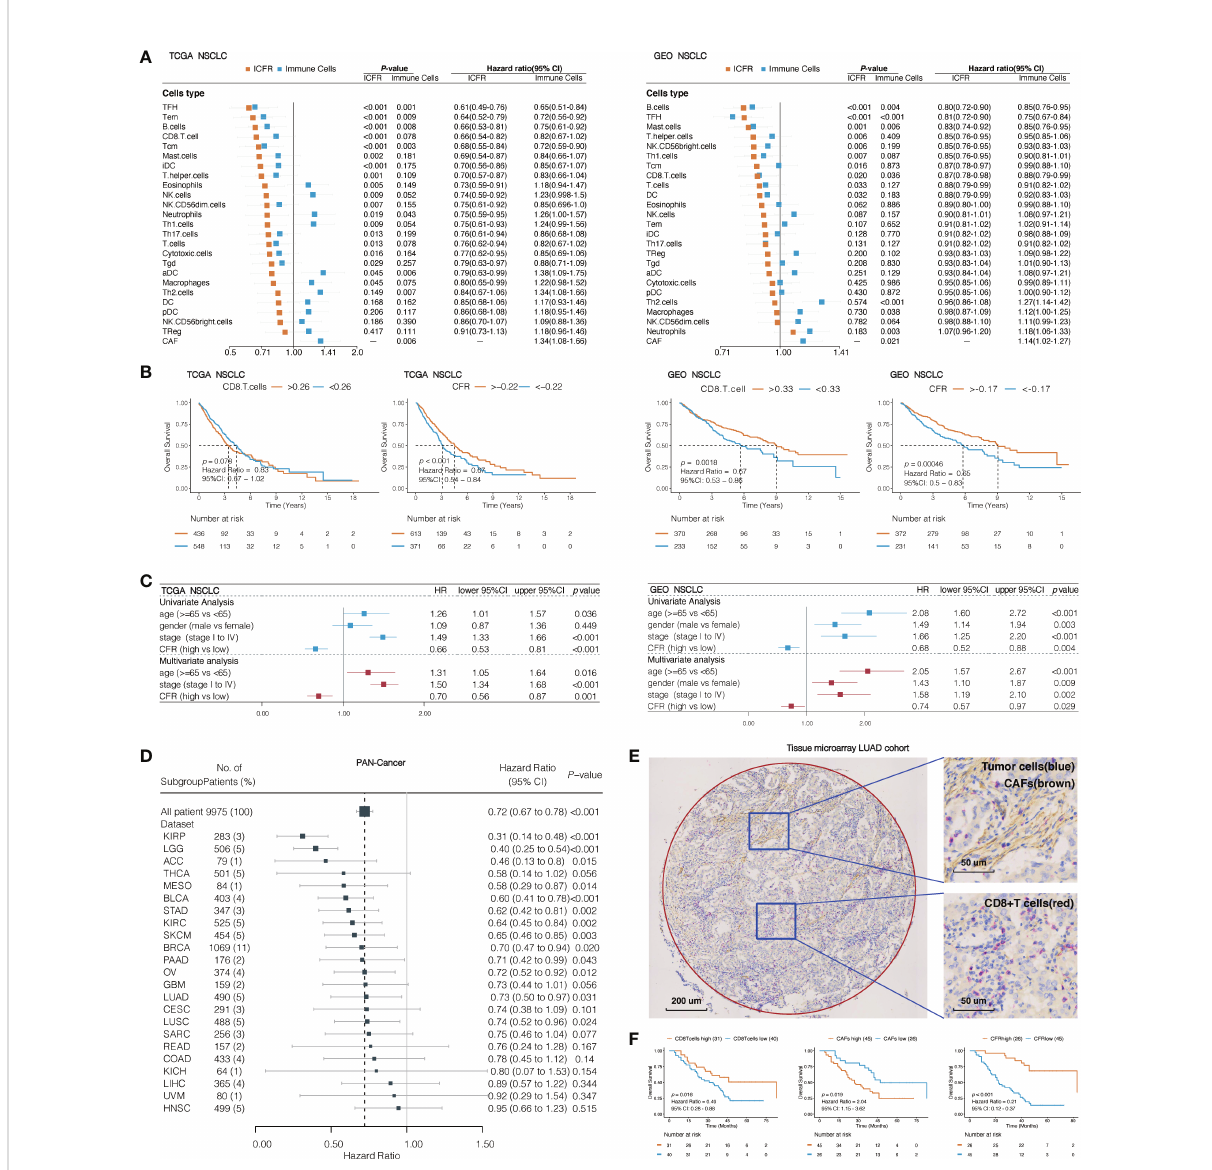
FIGURE 3 Association between immune cells/CAF ratio (ICFRs) and overall survival in lung cancer and pan-cancer cohort. (A) Prognostic value of 24 types of immune cells, CAFs, and ICFRs in non-small cell lung cancer from TCGA and GEO datasets. (B) Kaplan – Meier OS curves of CD8 T cells and CD8 + T cell/CAF ratio (CFR) in TCGA and GEO lung cancer cohort. (C) Univariate and multivariate analyses of the association between CFR and prognosis. (D) Association between CFR and overall survival in pan-cancer. Cancer types with abnormal or excessive con fi dence intervals were excluded, and only 23 cancer types were displayed. (E) Representative images indicated double staining for a -SMA (brown) and CD8 (red). The circle represents the sweep region. (F) Kaplan – Meier survival curves showing the effect of a -SMA, CD8, and CD8/ a